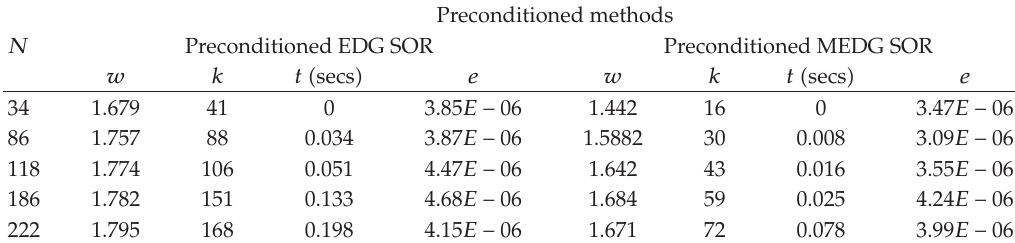
Table 2: Comparison of performances for the Preconditioned EDG SOR and MEDG